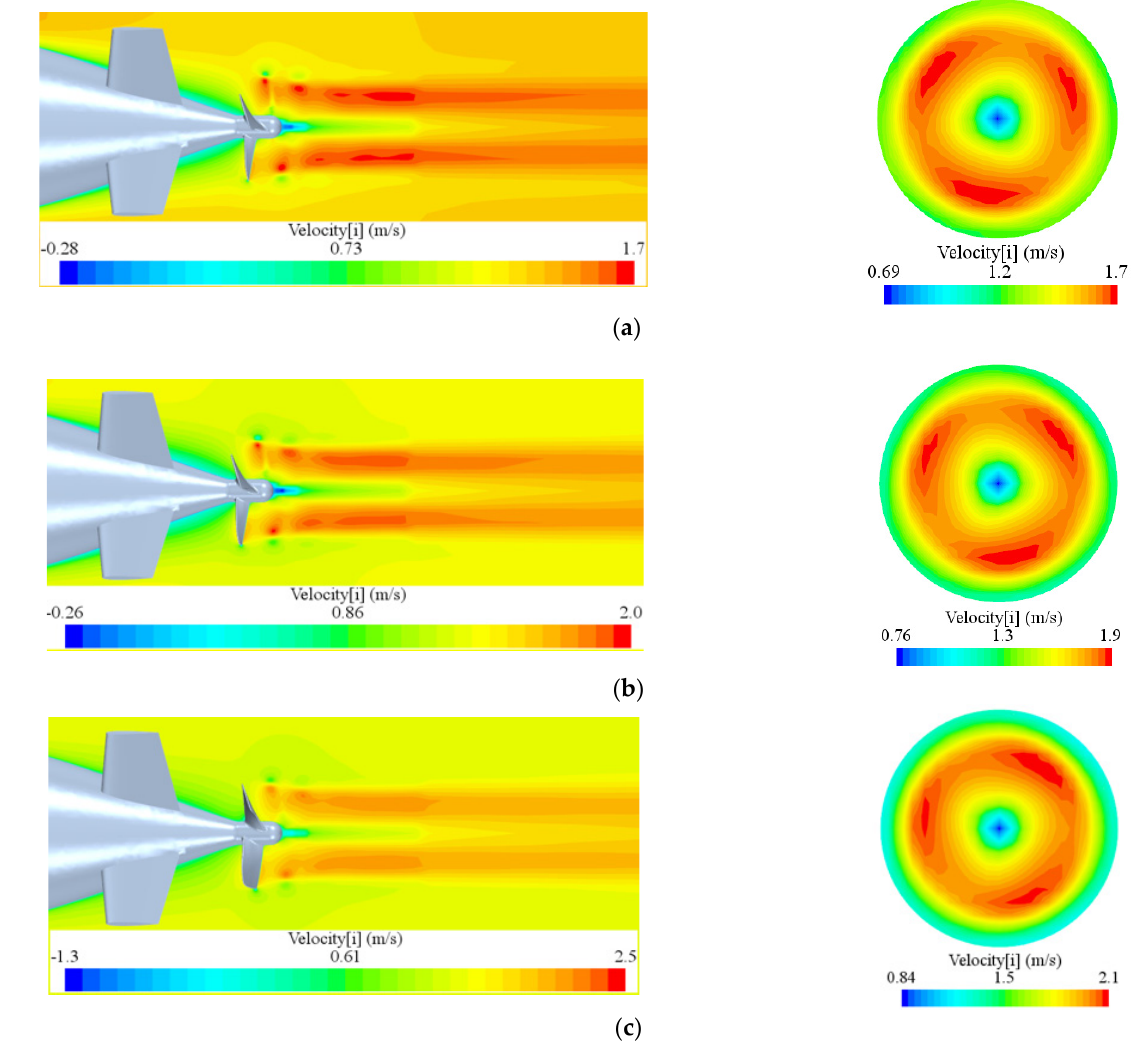
Figure 28. Velocity distribution of the hybrid-driven AUG with the single propeller with propeller rotation speeds of 720 rpm ( a ), 800 rpm ( b ), and 900 rpm ( c ).